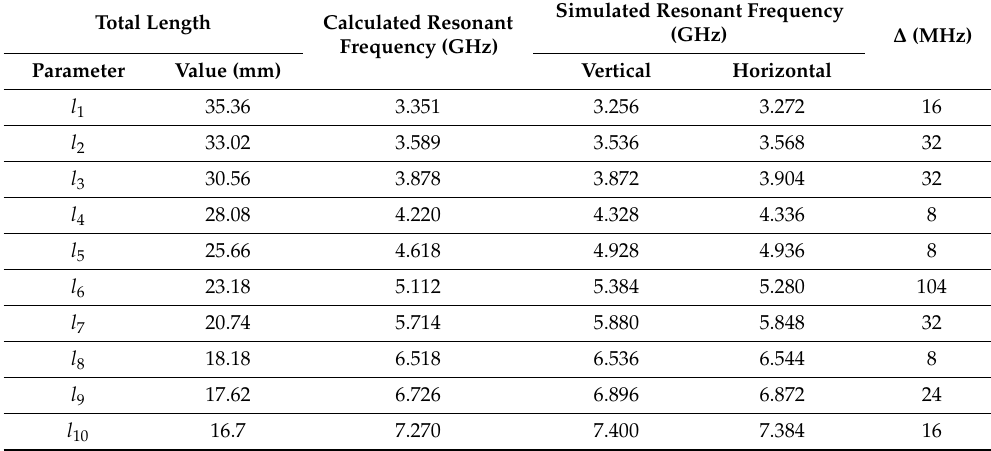
Table 3. Physical lengths and the corresponding resonance frequencies of the slot resonators. Simulated Resonant Frequency Total Length Calculated Resonant (GHz) ∆ Frequency (GHz)